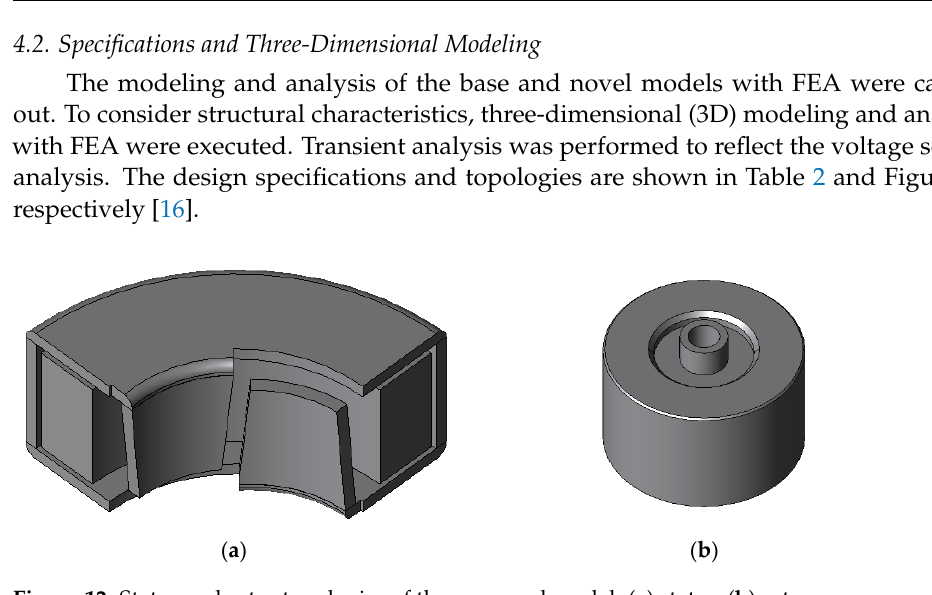
Figure 12. Stator and rotor topologies of the proposed model: ( a ) stator; ( b ) rotor.